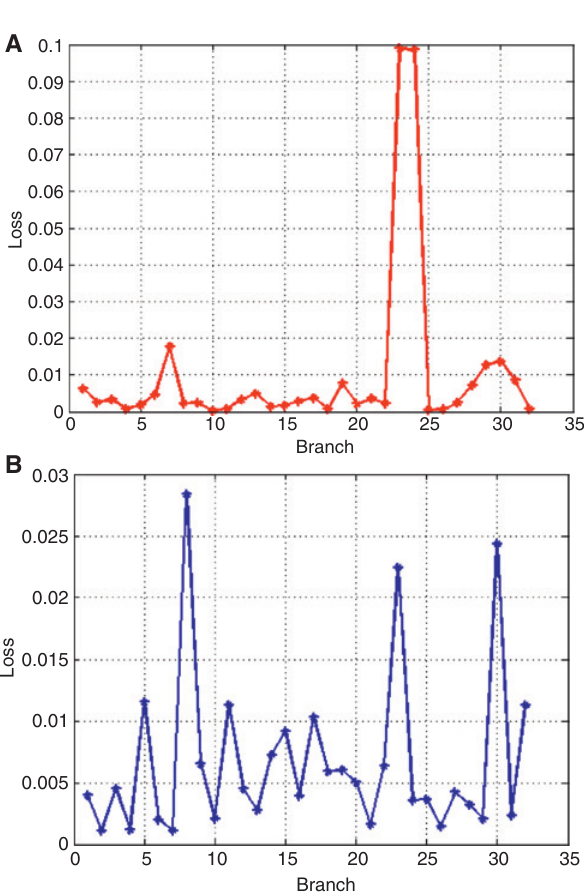
Figure 8: (A) Line Loss Using the B/F Sweep Method. (B) Line Loss Using the Proposed Method.